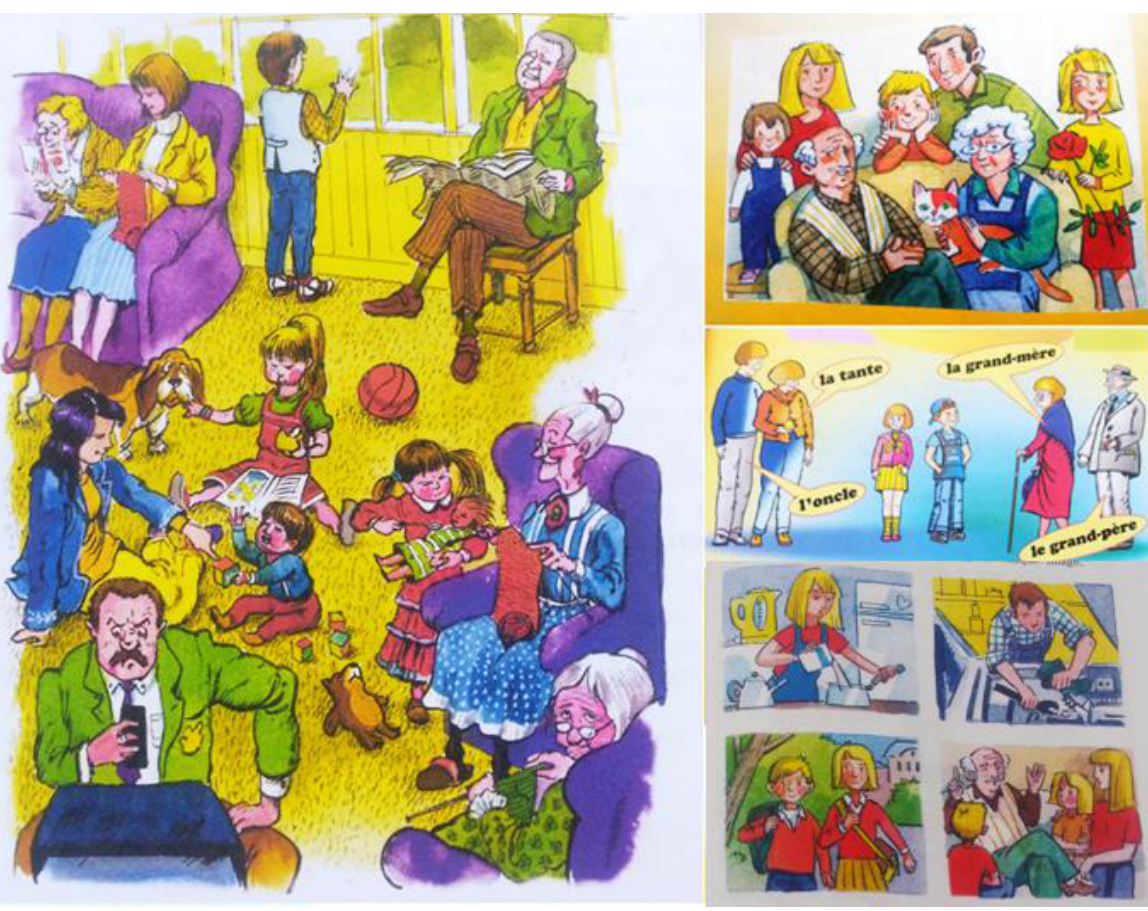
Fig. 2. The French textbooks illustrations proposed for the